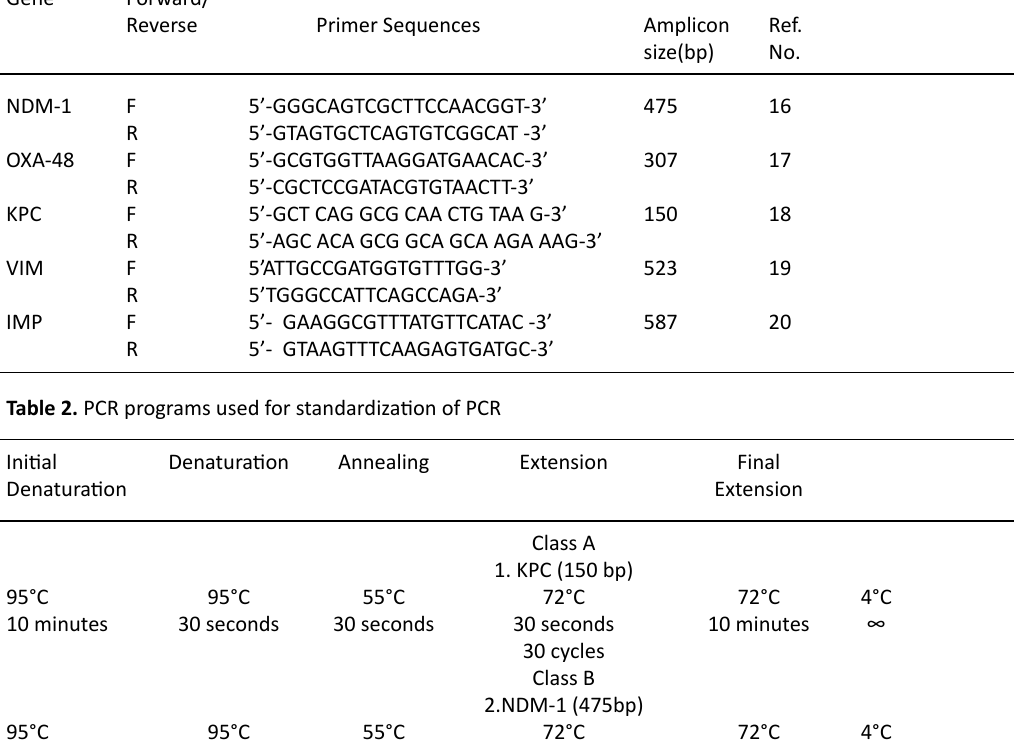
table 1. Primers used for carbapenemase encoded genes in the study Gene